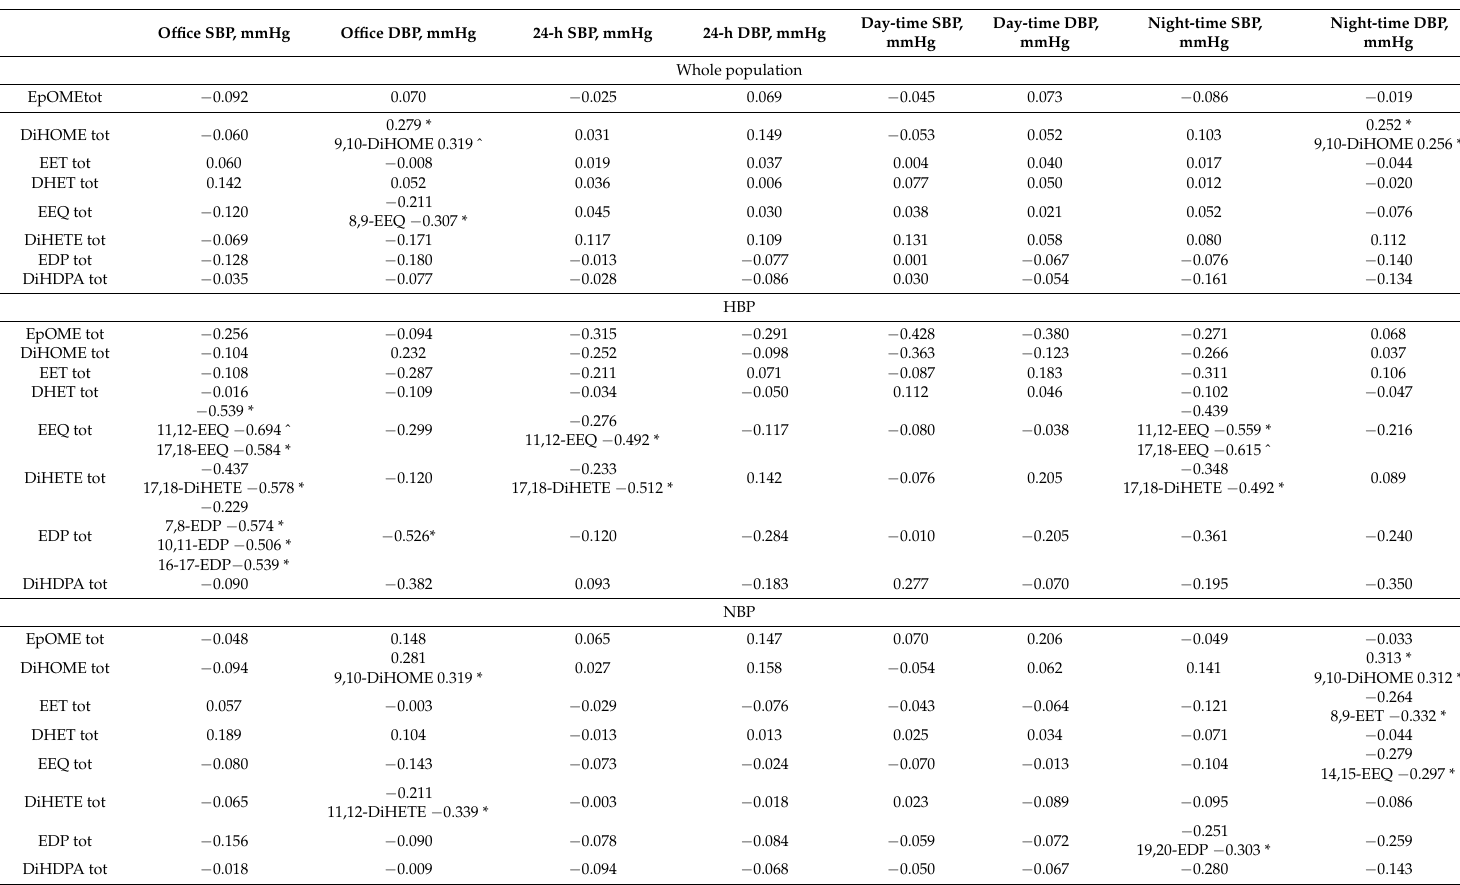
Table 4. Correlations of CYP450-epoxygenase/sEH metabolites of LA, AA, EPA and DHA with BP in the whole study population and in the two subgroups of high blood pressure and normal blood pressure obese